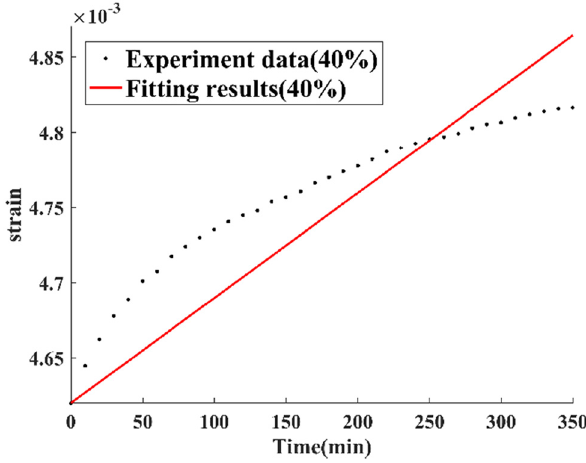
Figure 11: Fitting results based on the conventional Maxwell model and 60% stress